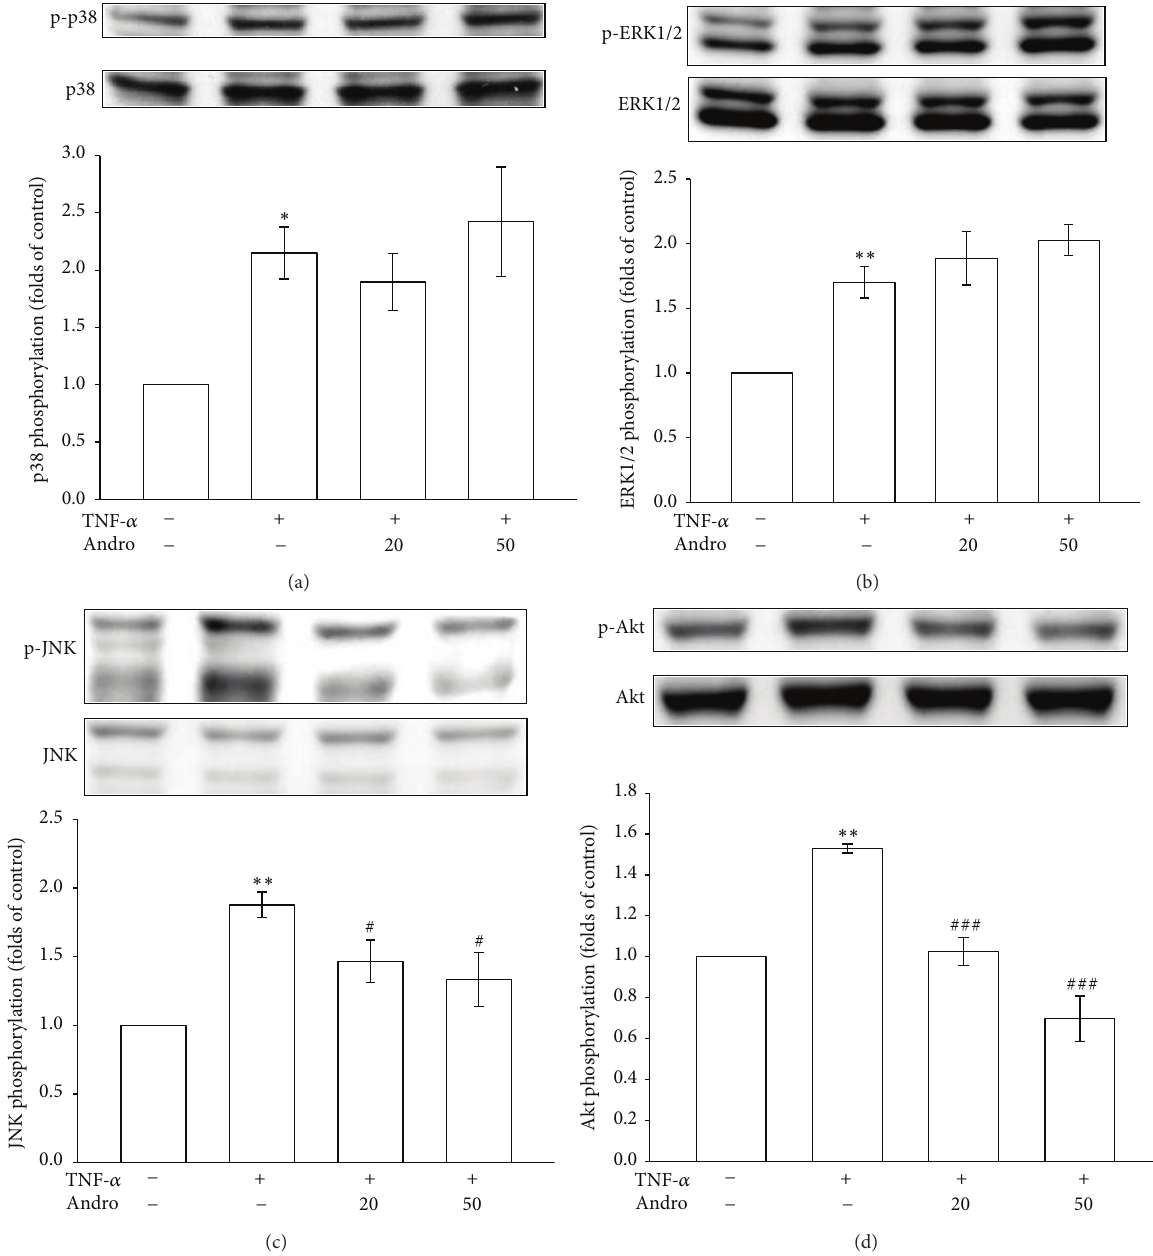
Figure 3: Effects of andrographolide on p38MAPK, ERK1/2, JNK, and Akt signaling pathways in TNF- 𝛼 -stimulated VSMCs. The VSMCs were treated with PBS (resting group) or pretreated with andrographolide (20 and 50 𝜇 M) or an equal volume of DMSO (solvent control) for 20 min, and TNF- 𝛼 (10ng/mL) was subsequently added for 10min. (a) p38MAPK phosphorylation, (b) ERK1/2 phosphorylation, (c) JNK phosphorylation, and (d) Akt phosphorylation were evaluated as described in Section 2. ∗ 𝑃 < 0.05 and ∗∗ 𝑃 < 0.01 compared with the resting group; # 𝑃 < 0.05 and ### 𝑃 < 0.001 compared with the TNF- 𝛼 group. The data are presented as the mean ± SEM ( 𝑛 = 3